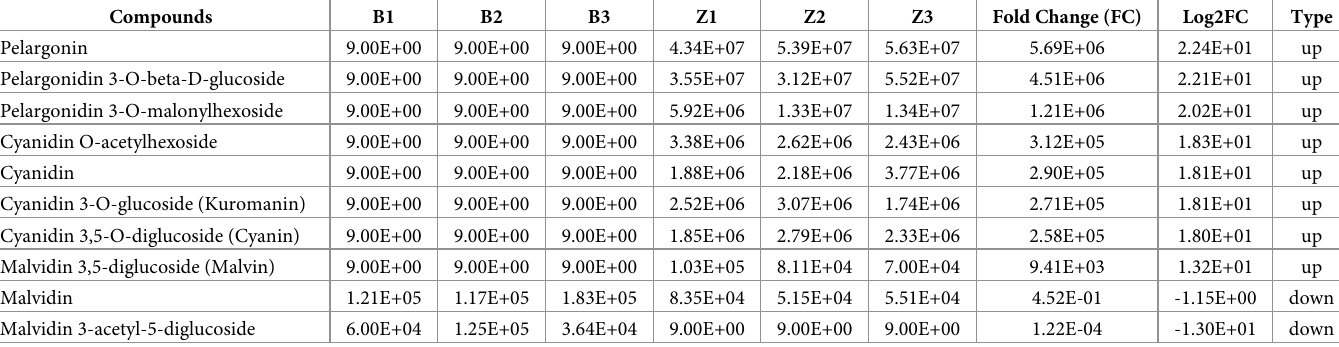
Note: Relative quantification was calculated by the area of each individual peak. FC: Fold